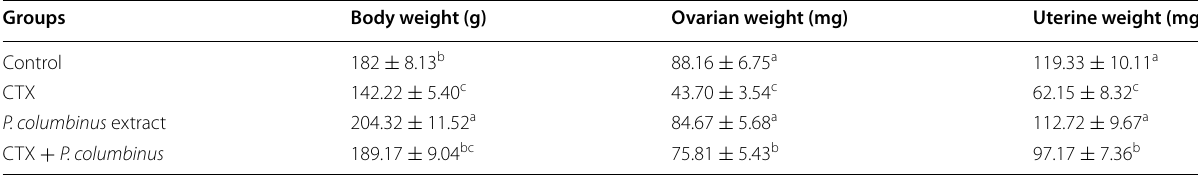
Each value represents mean SE ( n 8). a, b, ab, and c denote significant difference from normal-control, CTX-induced POF, P. columbinus extract control and POF ± = columbinus (before and after) groups, respectively, p < 0.05 (one-way ANOVA followed by post hoc Tukey)